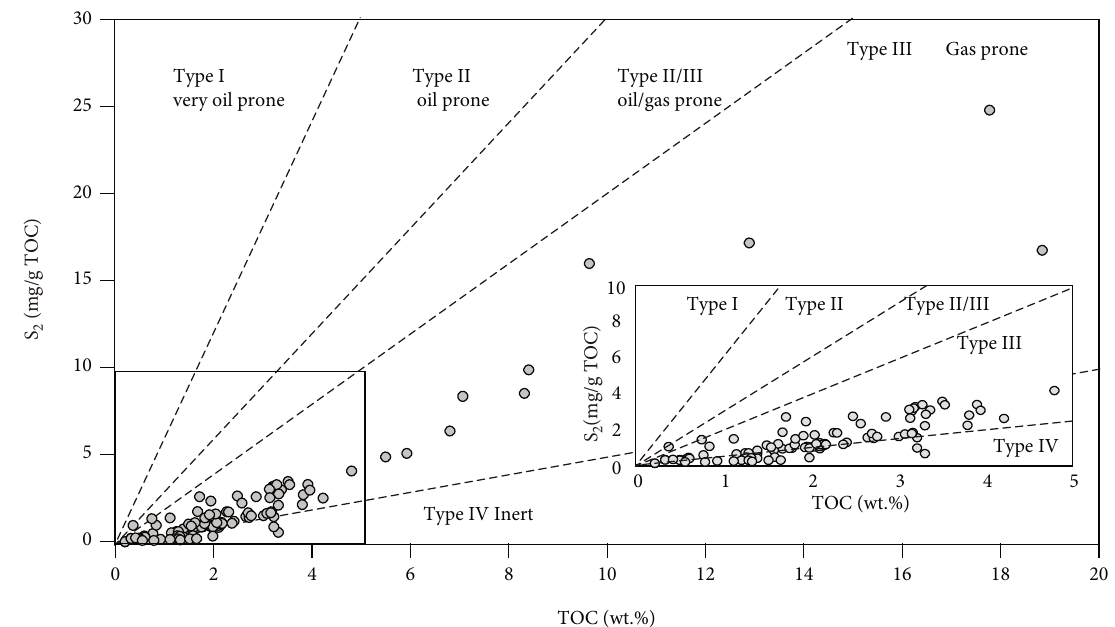
Figure 5: The TOC versus S 2 plot for the K 1 yc source rock samples (according to